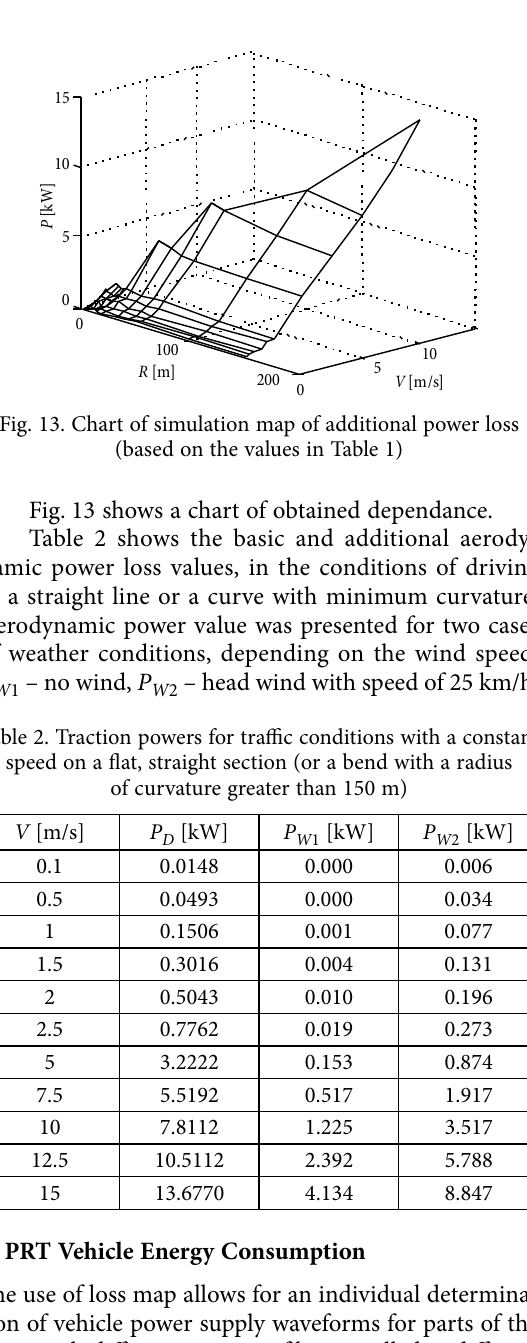
proximately 8.2. Expected energy consumption for the tested section is approx. E